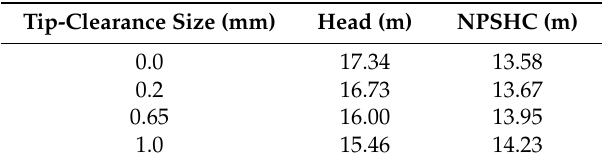
Table 4. Head and NPSHC (critical net positive suction head) values of pump with different tip clearances